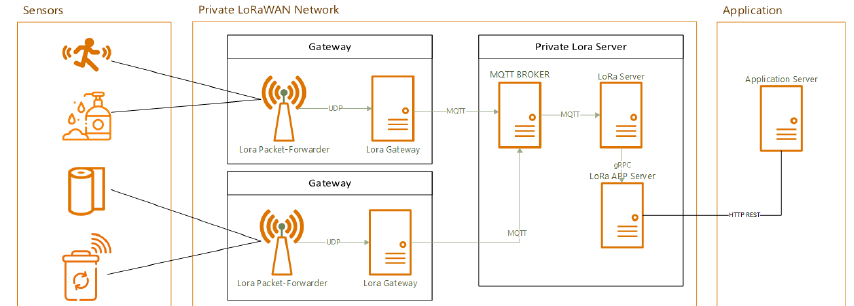
Figure 2. Long range wide area networks